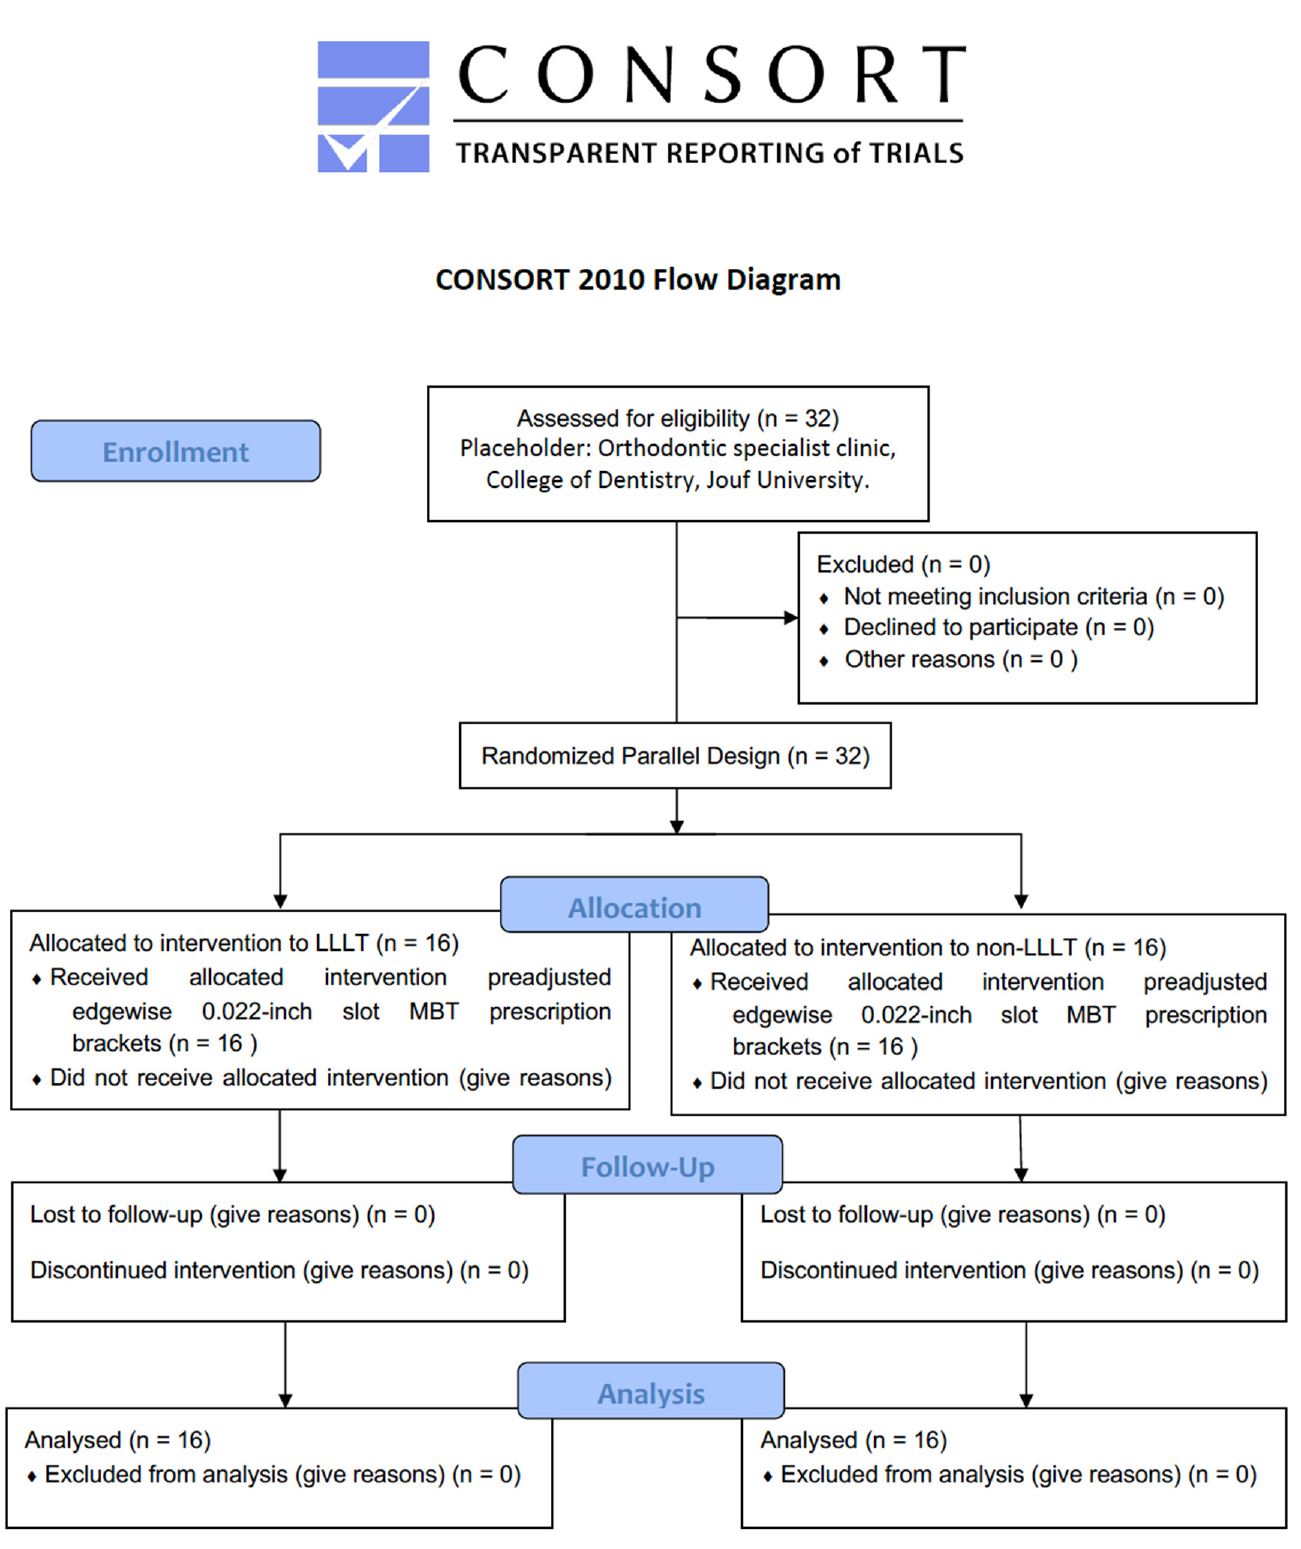
Figure 1. Subject allocation